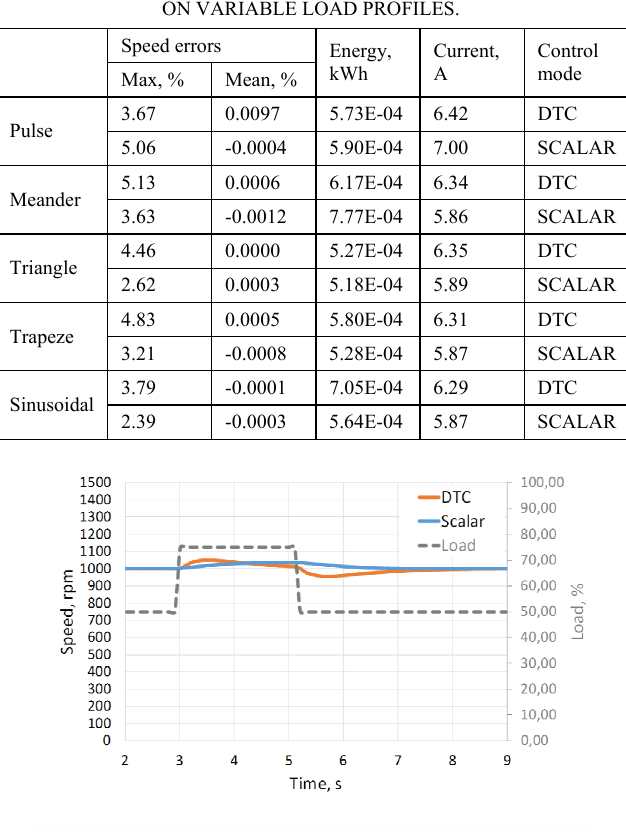
Fig. 13. Drive speed response on variable load of sinusoidal